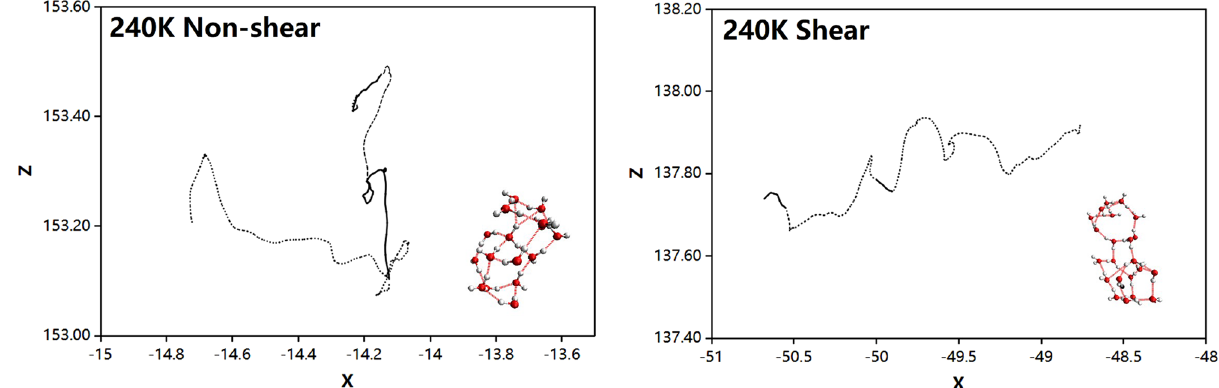
Figure 6. The projected trajectory of the centroid of the 4th- and 5th-level cluster masses at 240 K undergoing non-shear and shear. The solid line shows the trajectory during which the clusters exist. The dashed line shows the virtual trajectory during which the clusters are broken. Note that the scale factor for coordination and time is